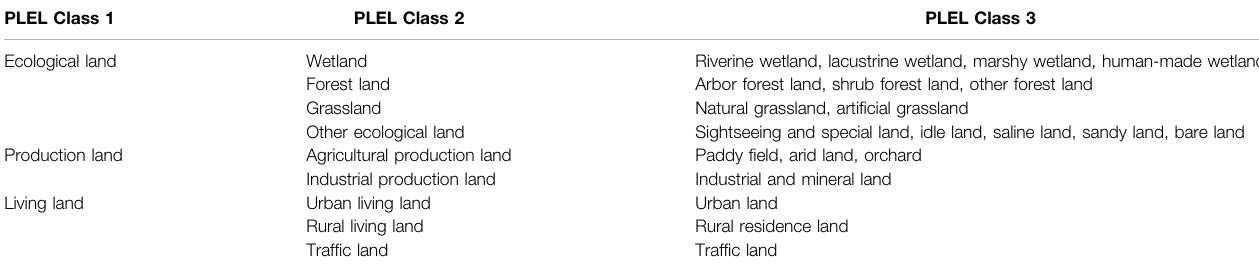
TABLE 1 | Production – living – ecological land (PLEL) classi fi cation